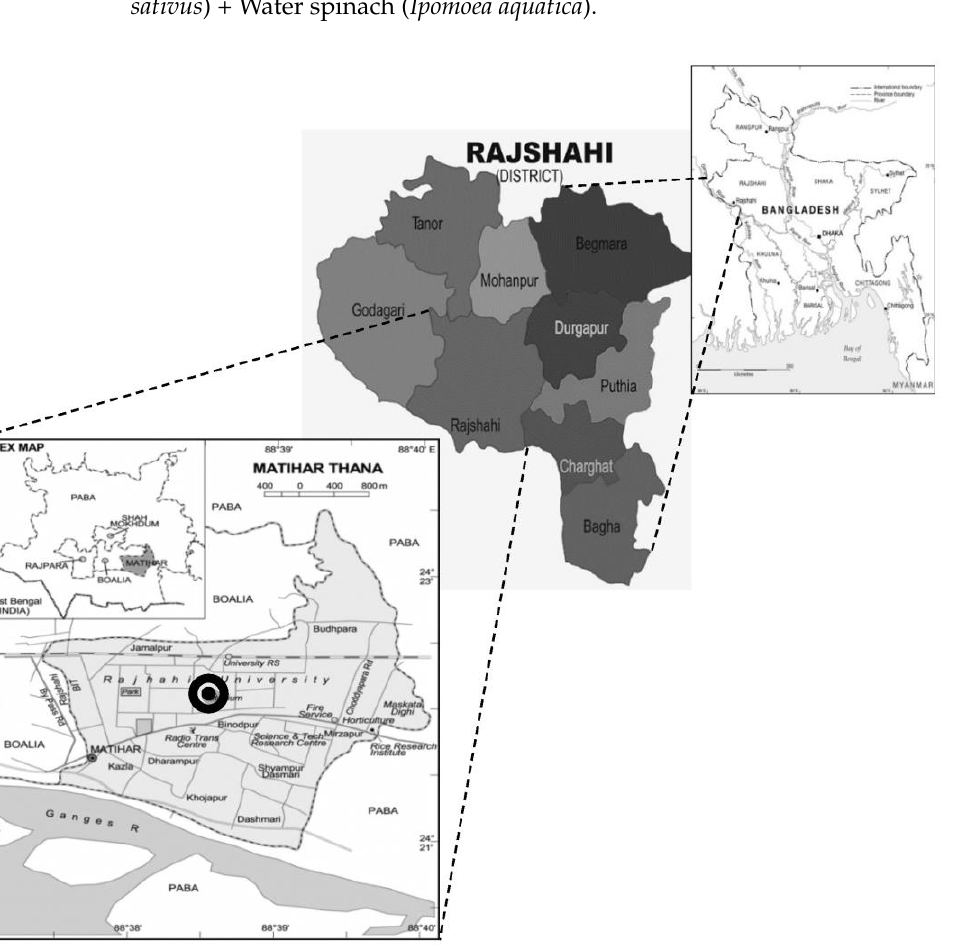
Figure 1. Location of the study area indicating the rice fields (black circle) at the Department of Agronomy and Agricultural Extension, University of Rajshahi,